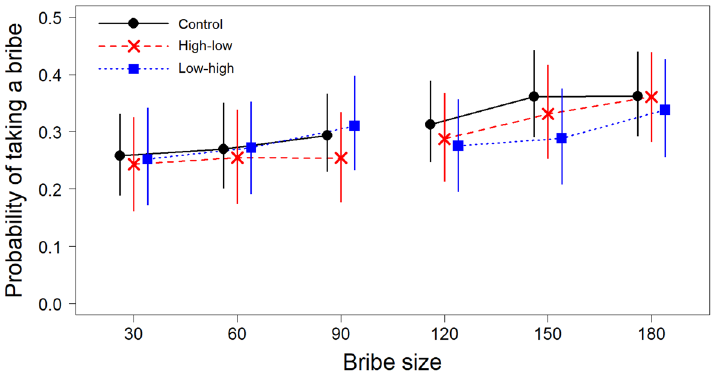
Figure 2. The predicted probability of taking a bribe based on a condition and bribe size. Unlike the model reported in the text, the model used in the figure did not include order effects, but included triple interaction between bribe size, bribe group, and condition. The main results were robust to the model specification, but the displayed model better recreates the observed averages. The error bars show 95% prediction intervals. The predictions and confidence intervals are based on bootstrapped estimates. Note that the displayed points are slightly shifted on the x-axis to not overlap.